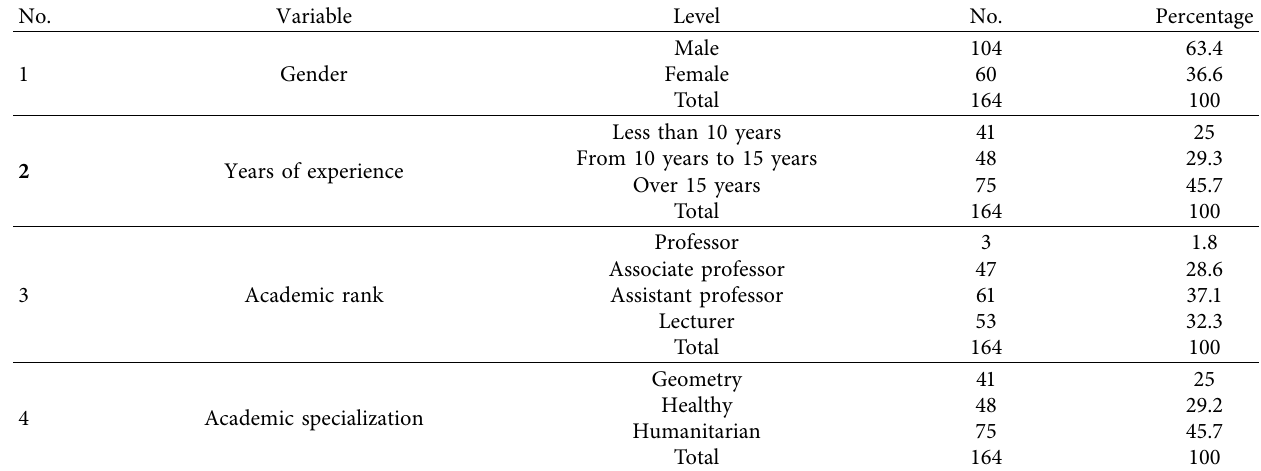
Table 1: A description of the variables of the study